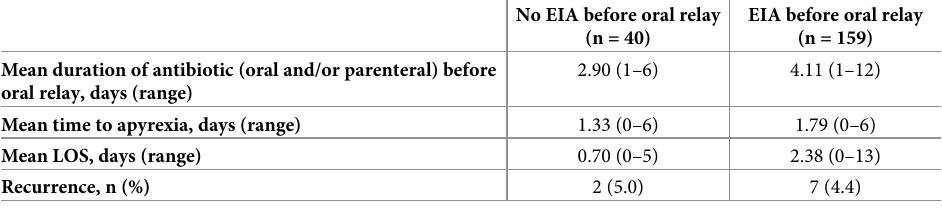
EIA: effective intravenous antibiotic therapy; LOS: length of hospital